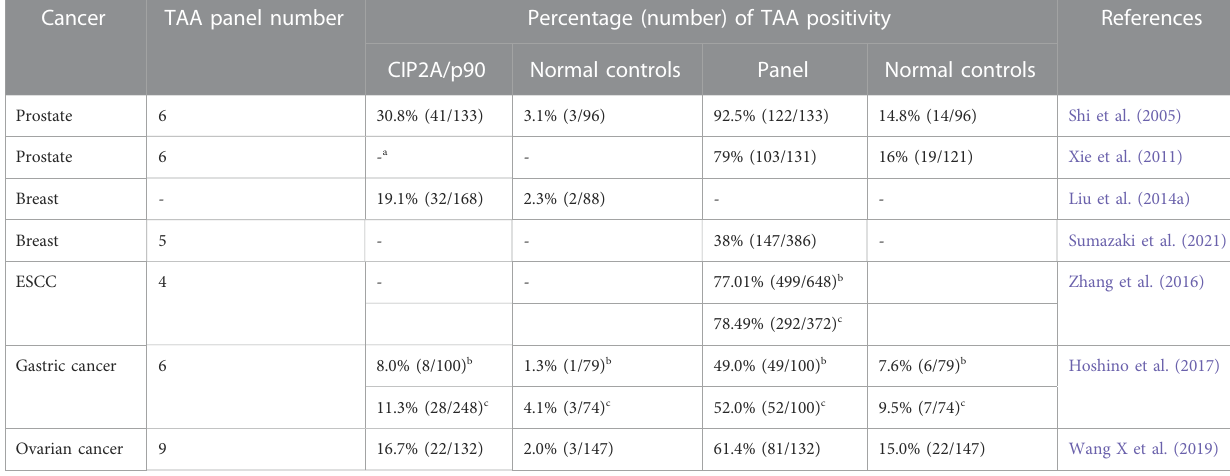
TABLE 3 Frequency of anti-CIP2A/p90 and the TAA panel in cancer patients and normal controls.